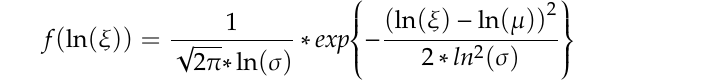
Figure 5. Qualitative analysis of PS / PMMA blends on neutral surfaces and on surfaces modified by m-AFM. ( a ) Overview SEM image of PS / PMMA blend in two modified areas (stripes) and their direct pristine vicinity covered with neutral brush layer, ( b ) close-up of the part of ( a ) indicated by the box drawn in light blue, ( c ) explanatory sketch of the architecture of the droplet sketched on the left side of ( b ) before and after the oxygen plasma treatment, ( d ) explanatory sketch of surface on the right side of image ( b